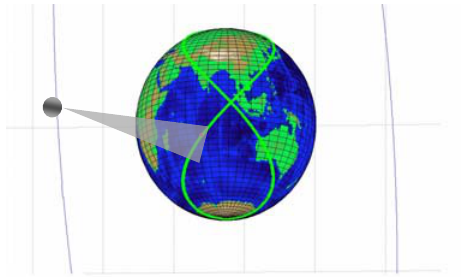
Figure 1. Orbit and ground track of GEO SAR satellite